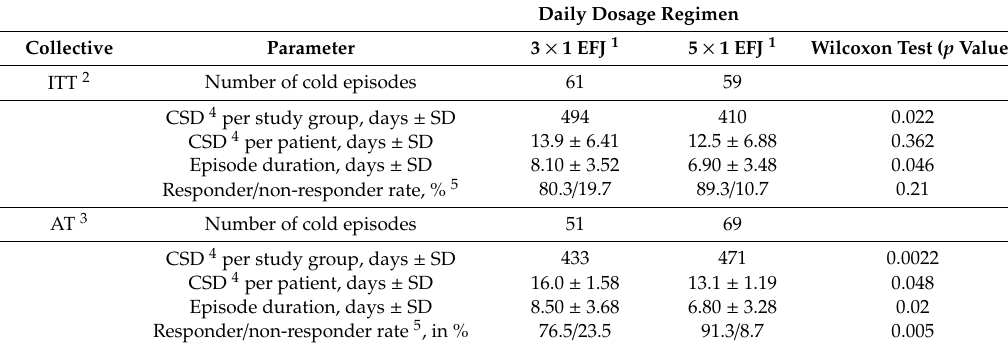
indicates cumulative number of sick days per study group overall and on average per patient during the time of observation. 5 Overall ratio of resolved episodes (responder) vs. unresolved episodes (non- responder) after 10 days of treatment.